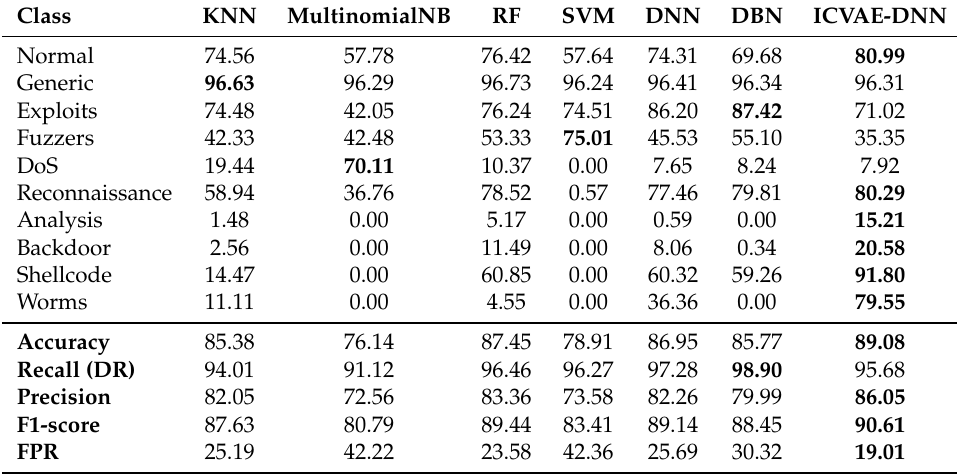
Table 11. Comparison of detection performance for different classification methods on the UNSW-NB15 dataset